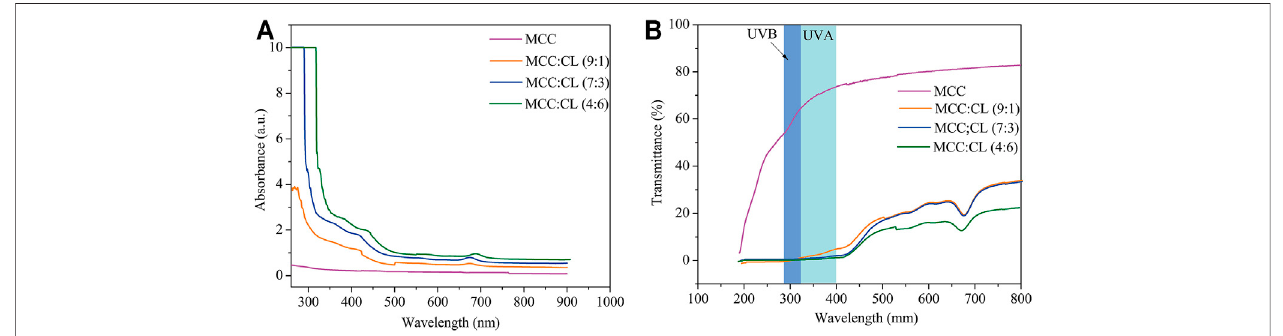
FIGURE 8 | UV and visible light absorbance (A) and transmittance (B) of the MCC fi lm and MCC:CL biocomposite fi